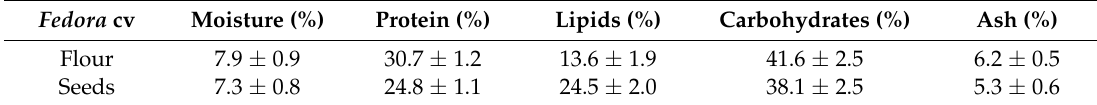
Table 1. Proximate composition of flour and seeds of hemp Fedora